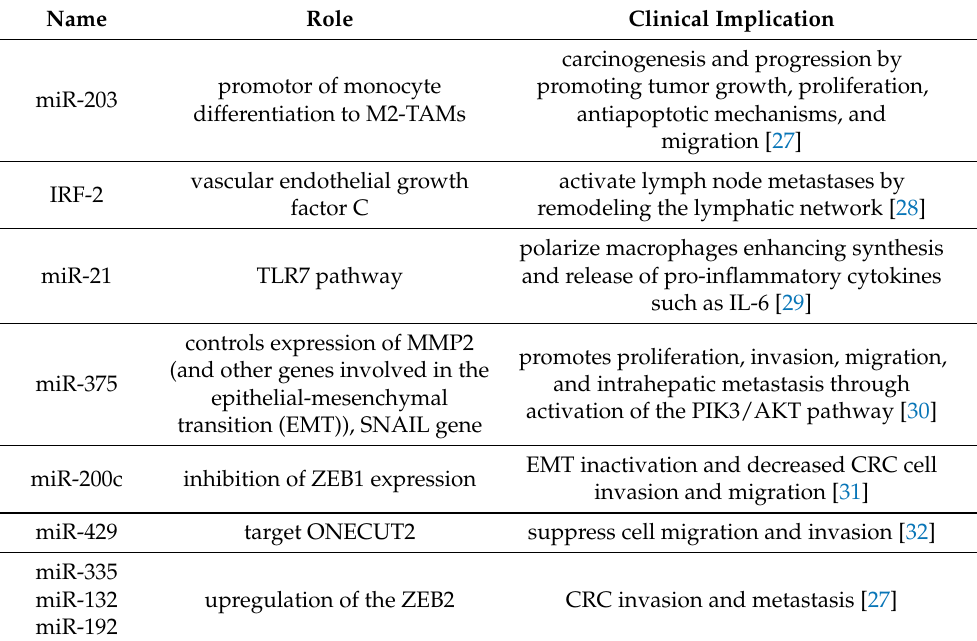
Table 1. Exosomes in colorectal metastatic